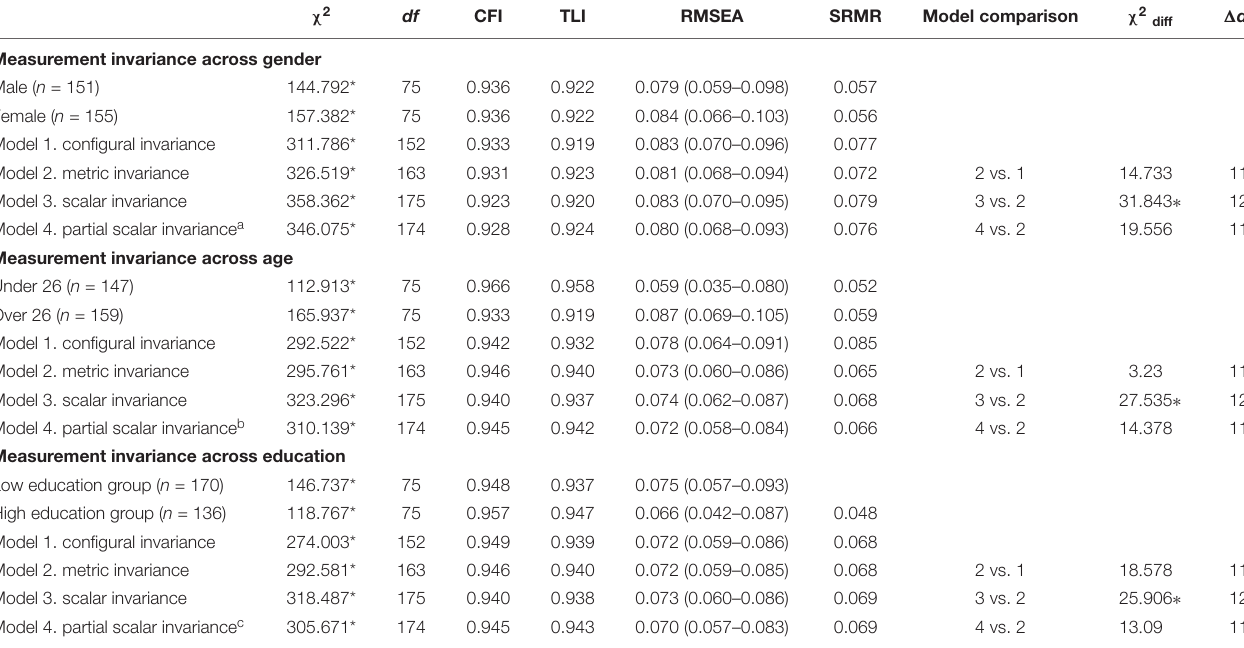
TABLE 4 | Tests for measurement invariance of PAIS measurement model across gender, age, and education: summary of goodness-of-fit